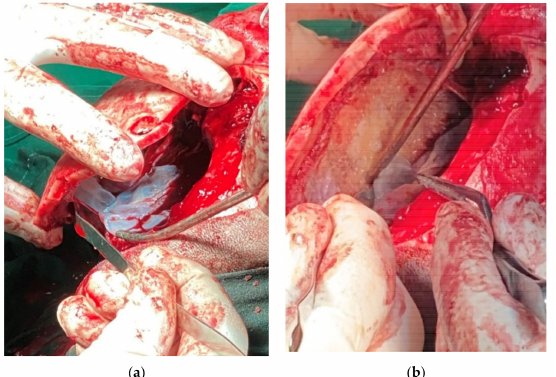
Figure 6. Intraoperative view. Cyst extravasation at the moment of craniotomy. ( a ) cyst rupture at the time of the craniotomy; ( b ) the cyst membrane infiltrates the frontal